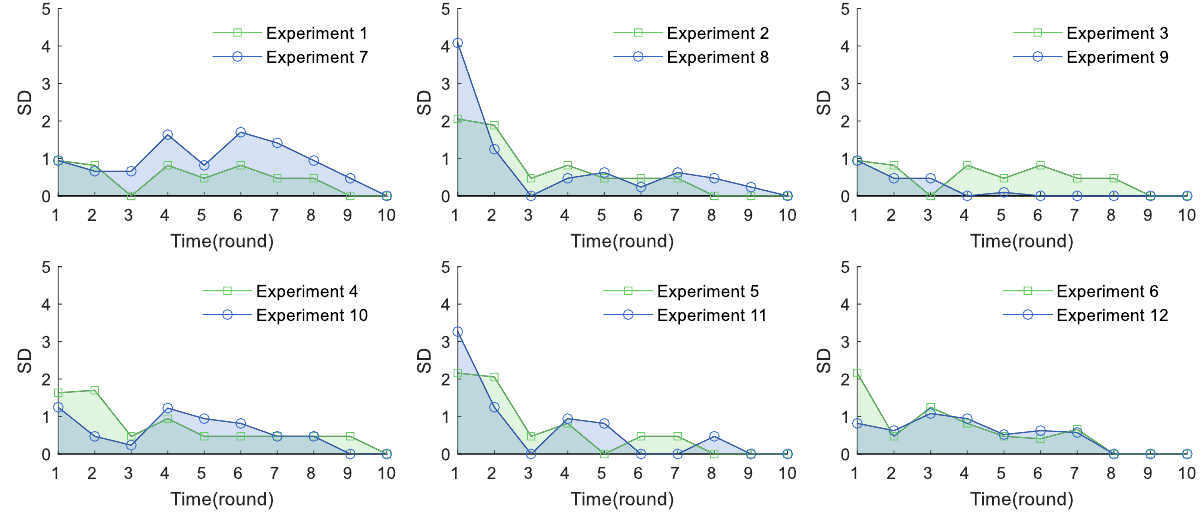
Figure 4. Effects of communication on free-riding behaviour.